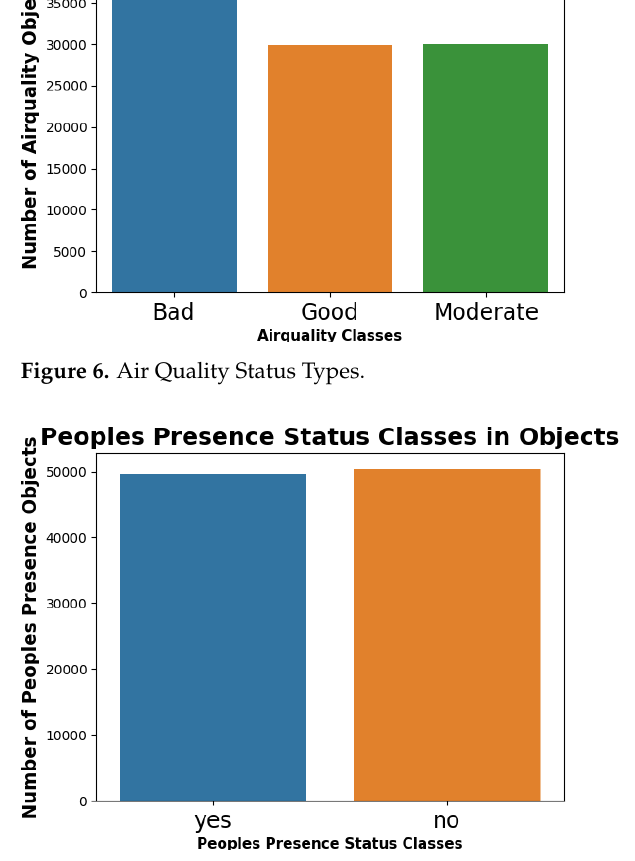
Figure 7. People Presence Status